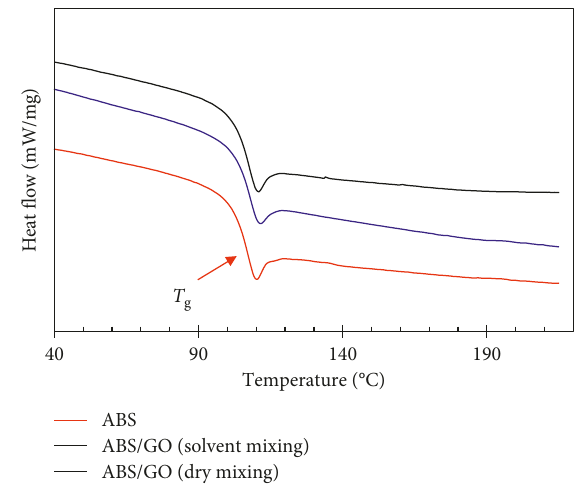
Figure 3: Melting temperature of the ABS filament, ABS/GO (solvent mixing), and ABS/GO (dry mixing) composite filaments from the DSC second heating scan.